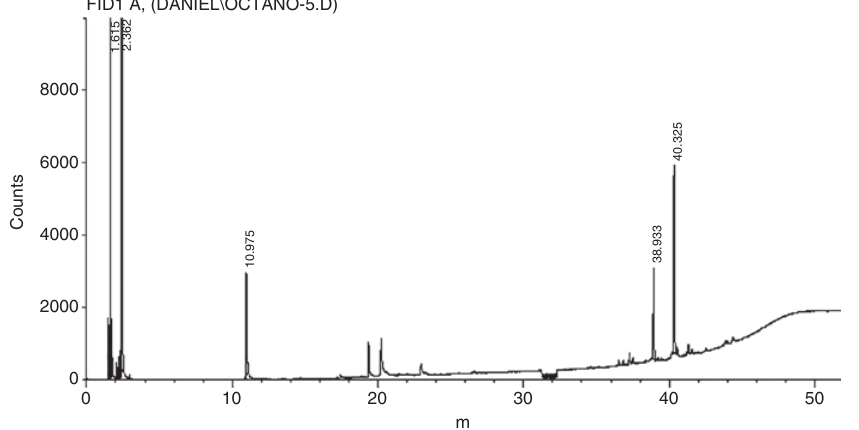
Figure 4: Gas chromatogram of the optimised parameters for aldol condensation of citral and 2-octanone.